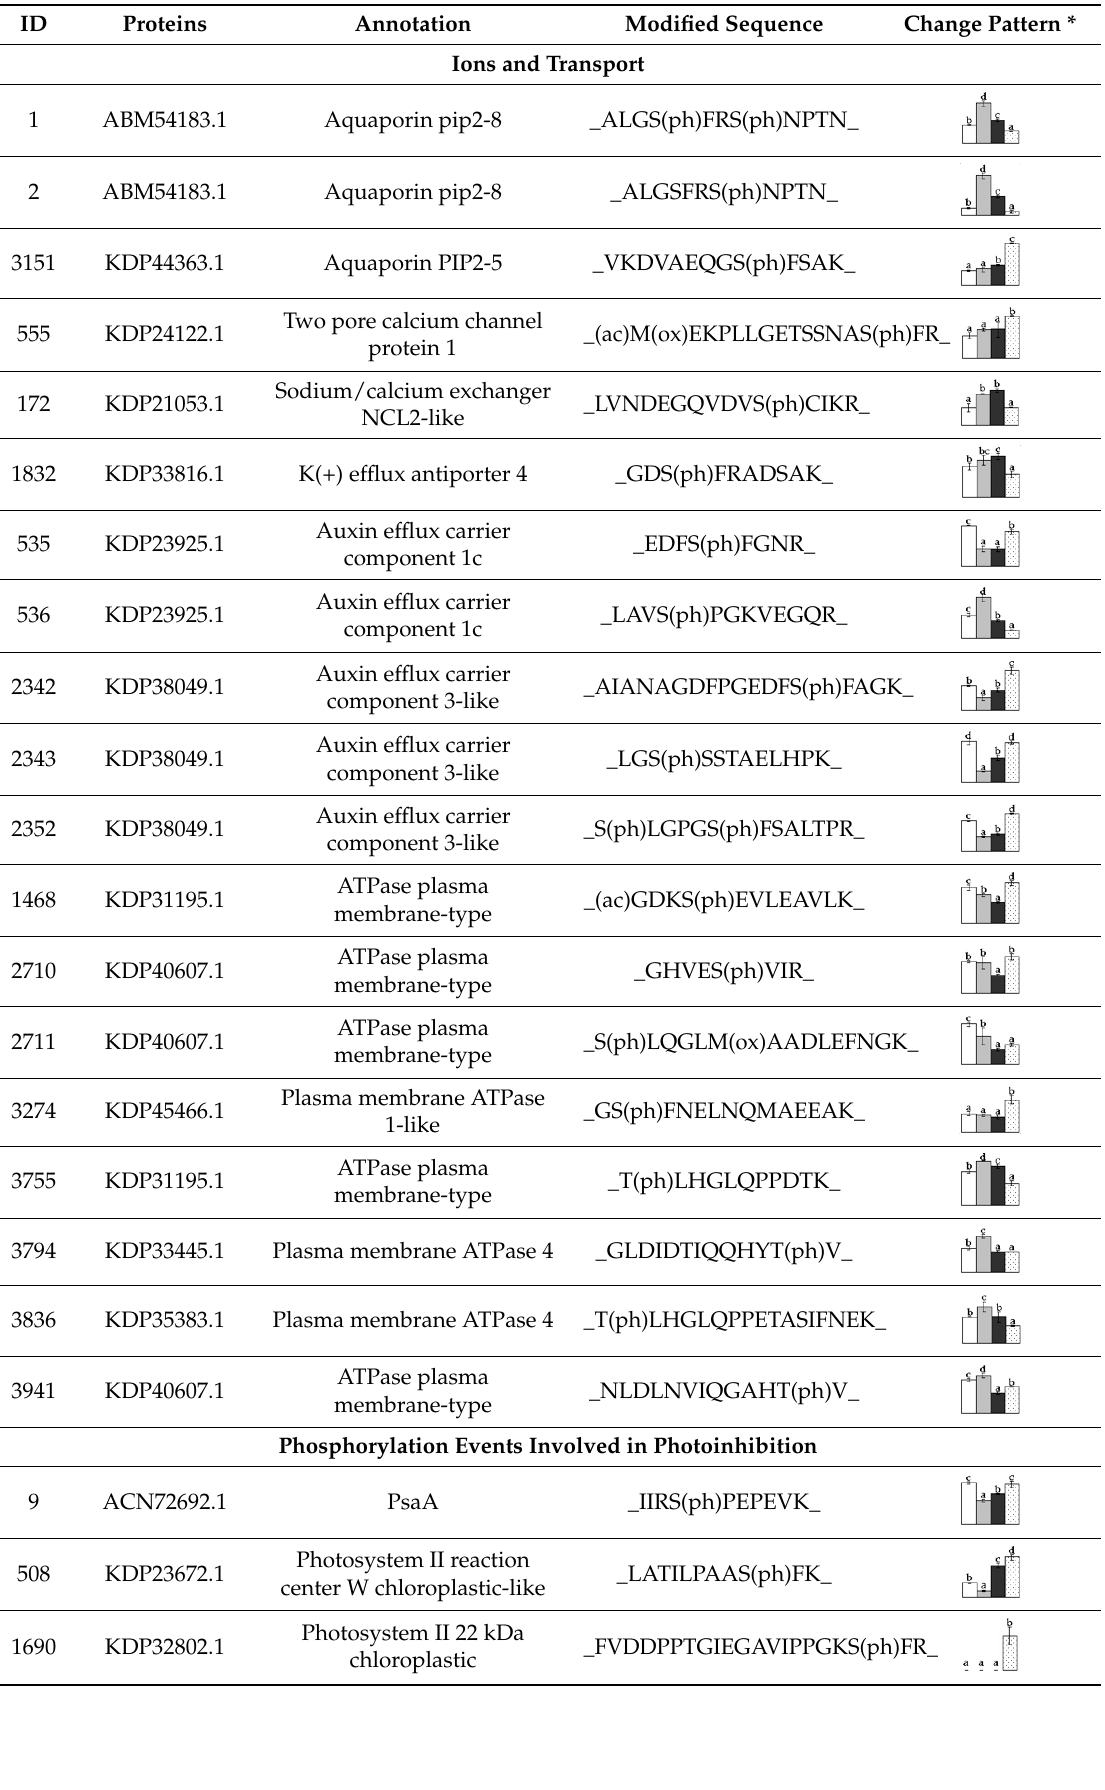
Table 1. 110 significantly changed phosphoproteins from J. curcas seedling in response to chilling.